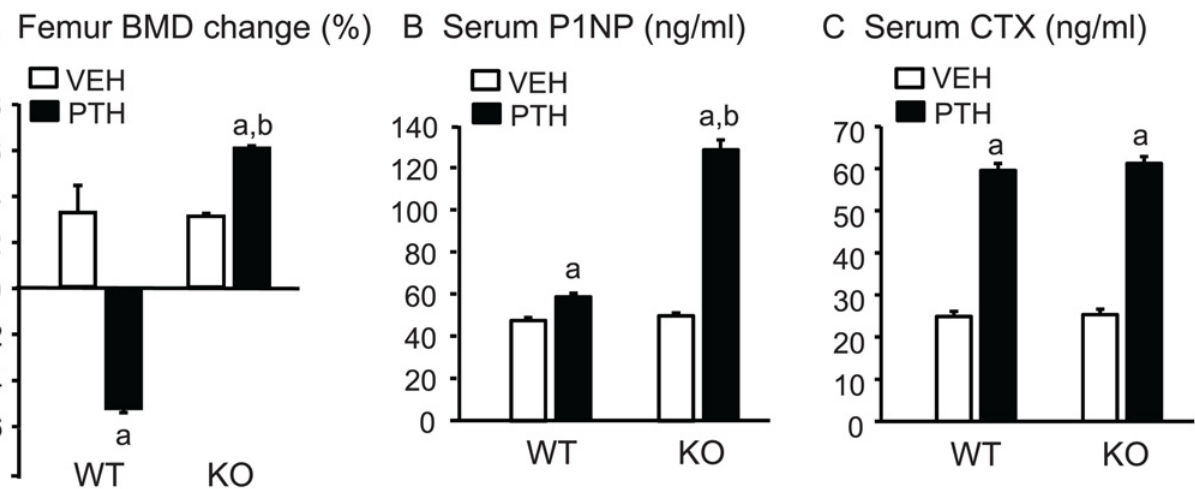
Fig 1. Femoral BMD and serum markers of bone turnover in mice infused for 12 days. A. BMD was measured invivo at beginning and end of infusion with vehicle (VEH) or PTH (40 μ g/kg/d) in WT and Cox2 KO mice and the percent change calculated relative to the beginning BMD for each mouse. B, C. Serum parameters for bone formation (P1NP) and bone resorption (CTX) were measured at the time of euthanasia. Bars are means ± SEM for 7 WT and 7 KO mice treated with vehicle and 8 WT and 8 KO treated with PTH. a Significant effect of PTH, p < 0.01. b Significant effect of genotype, p <